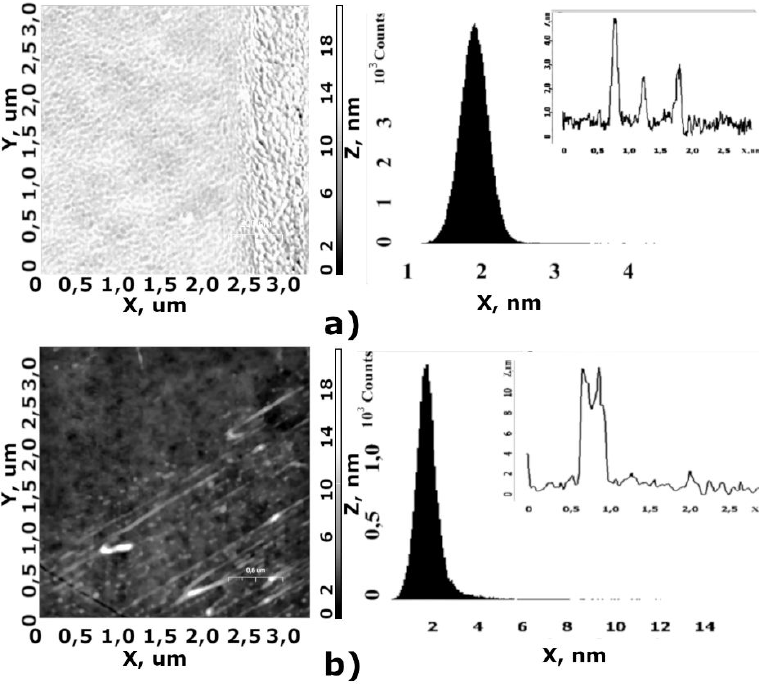
Fig. 3. Morphology, distribution of heights, revealed characteristic profilogram: а) 7 nm; b) 10 nm.